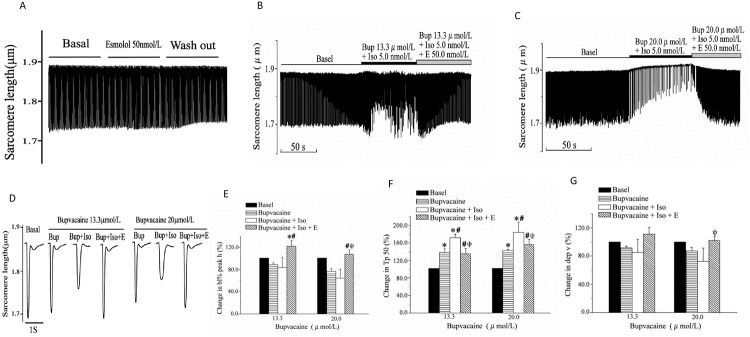
Isoprenalin aggravated bupivacaine-induced myocardial dysfunction, and esmolol inhibited the aggravation.(A) Representative sarcomere-shortening trace before and after exposure to esmolol. (B) and (C) Representative sarcomere-shortening trace perfused with bupivacaine in the presence or absence of bupivacaine + isoprenalin, with or without esmolol, in succession. (D) Averaging ten successive signals of (B) and (C). (E), (F) and (G) Effect of esmolol, isoprenalin and bupivacaine on bl% peak h, Tp50 and dep v. Data are the mean ± SD. *P < 0.05, vs. basal amplitude. †P < 0.05, vs. bupivacaine; ‡P < 0.05, vs. bupivacaine + isoprenalin.